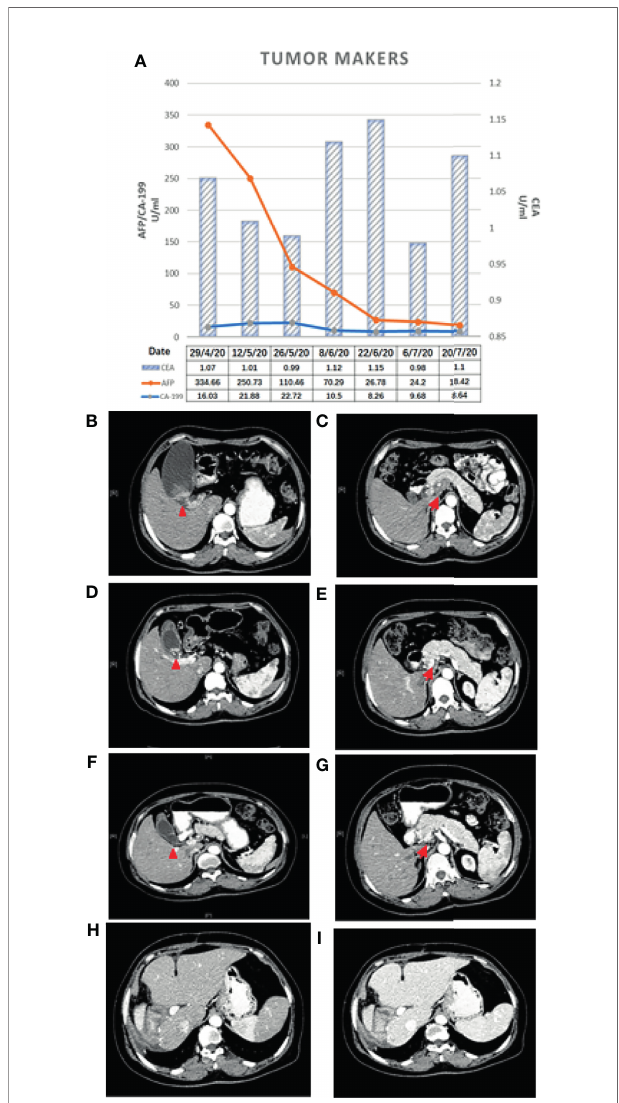
FIGURE 1 | (A) Changes in the tumor makers. (B , C) Baseline CT scan. (D , E) CT scan after the fi rst treatment cycle. (F , G) CT scan after the second treatment cycle. Changes in CT fi ndings: the primary gallbladder cancer and metastatic lymph nodes shrank after treatment with gemcitabine + albumin- bound paclitaxel combined with camrelizumab for two cycles. (H , I) CT examination after surgery. No recurrence or metastasis was found on abdominal CT at 14 months. The red triangle denotes the primary lesion and the red arrow indicates the metastatic lymph nodes posterior to the